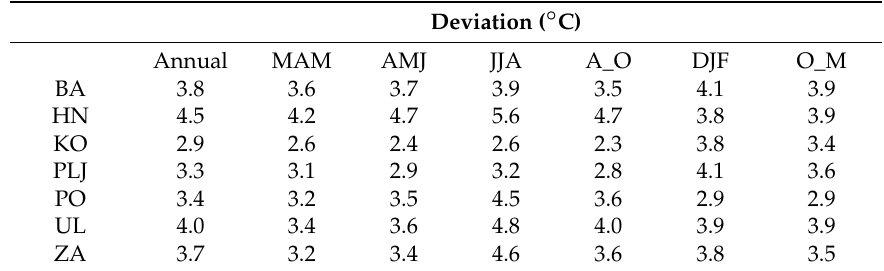
Table 6. The deviation of the normal temperature for 2071–2100 with respect to the referent climatology of 1981–2010.